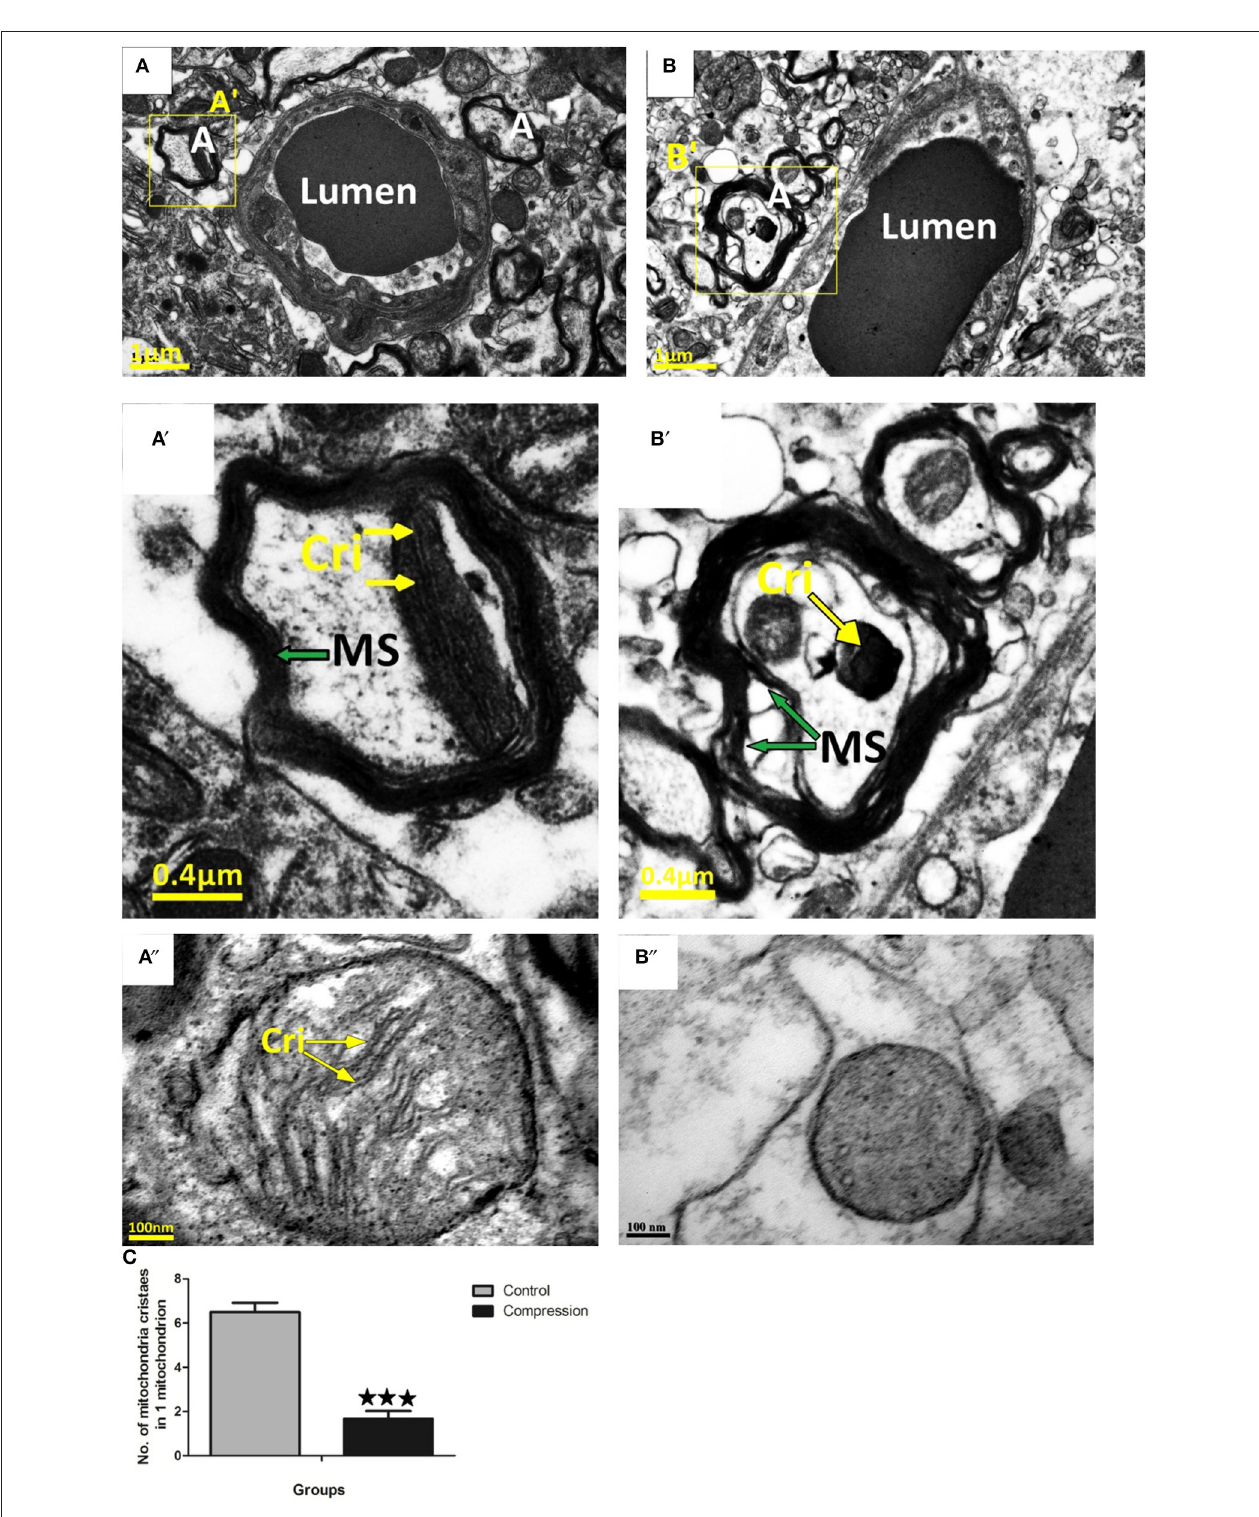
FIGURE 8 | Myelin sheath of axon in control group was intact and homogeneous (A,A ′ ,A ′′ ) , mitochondria in myelinated axons were normal. Loose myelin sheath and damaged mitochondria were observed in the compression group (B,B ′ ,B ′′ ) . The numbers of mitochondria cristaes in 1 mitochondrion declined significantly after compression (C) , the number of mitochondria analyzed per group was 30, sampled from 12 rats per group. MS, Myelin Sheath; Cri, Mitochondria Cristae; A, Axons. *** P < 0.001 relative to controls.